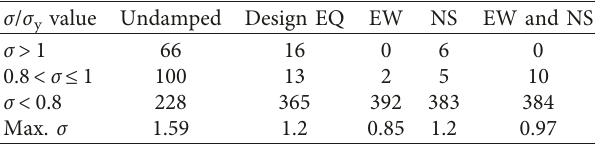
Table 4: Number of members according to σ / σ